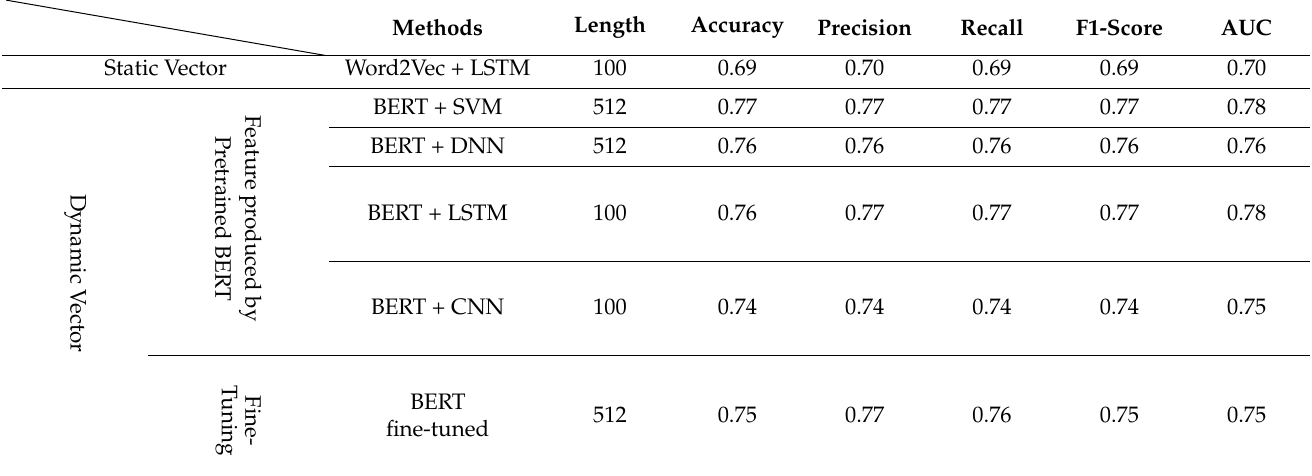
Table 5. Classification results using the Dianping dataset.